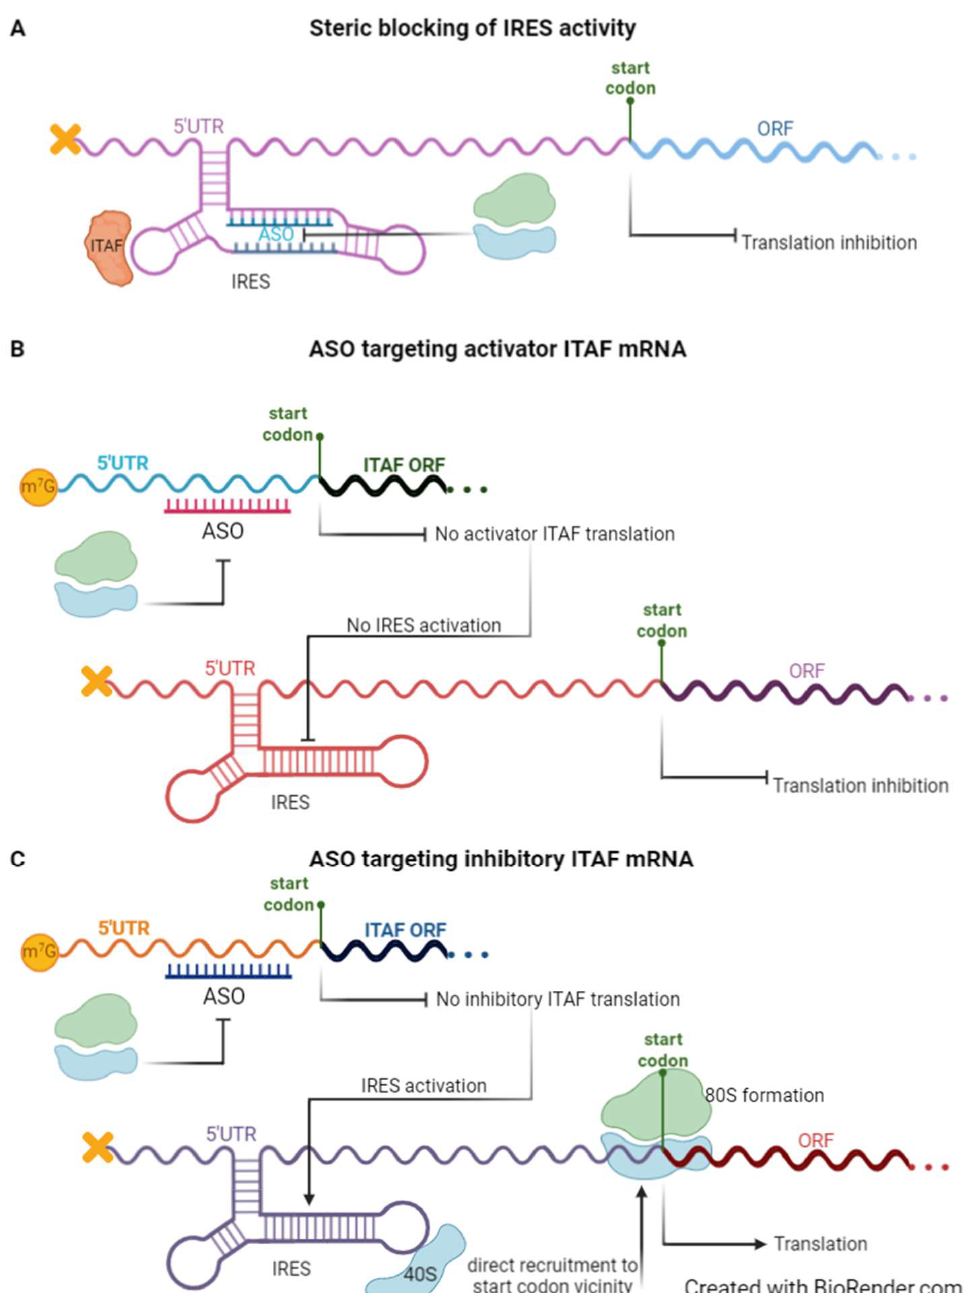
Figure 2. A model proposing the use of antisense oligonucleotides (ASOs) to modulate internal ribosome entry site (IRES) or IRES trans -acting factor (ITAF) activity and further protein expression. ( A ) An ASO targeting an IRES responsible for translating a pathogenic protein would lead to the disruption of IRES activity and hence hinder protein synthesis. ( B ) ASO targeting activator ITAF mRNA. If the ITAF enhances IRES activity, disrupting its expression would lead to impaired IRES activity and subsequent protein synthesis inhibition. ( C ) ASO targeting inhibitory ITAF mRNA. If the ITAF represses IRES activity, disrupting its expression would allow IRES activation and consequent regular protein